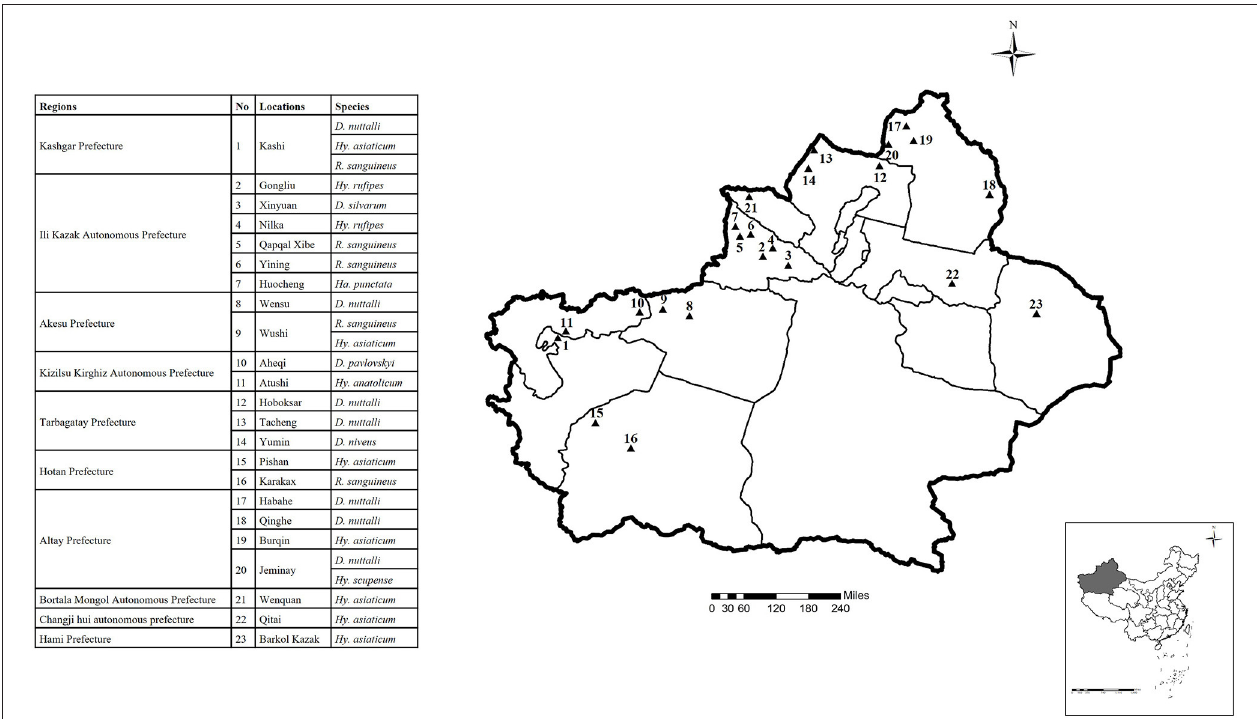
FIGURE 1 | Locations of the sample sites for tick collection in the border areas of Xinjiang (different locations are coded by number; 1-23 indicate the sampling points). The map was made by ArcMap 10.2